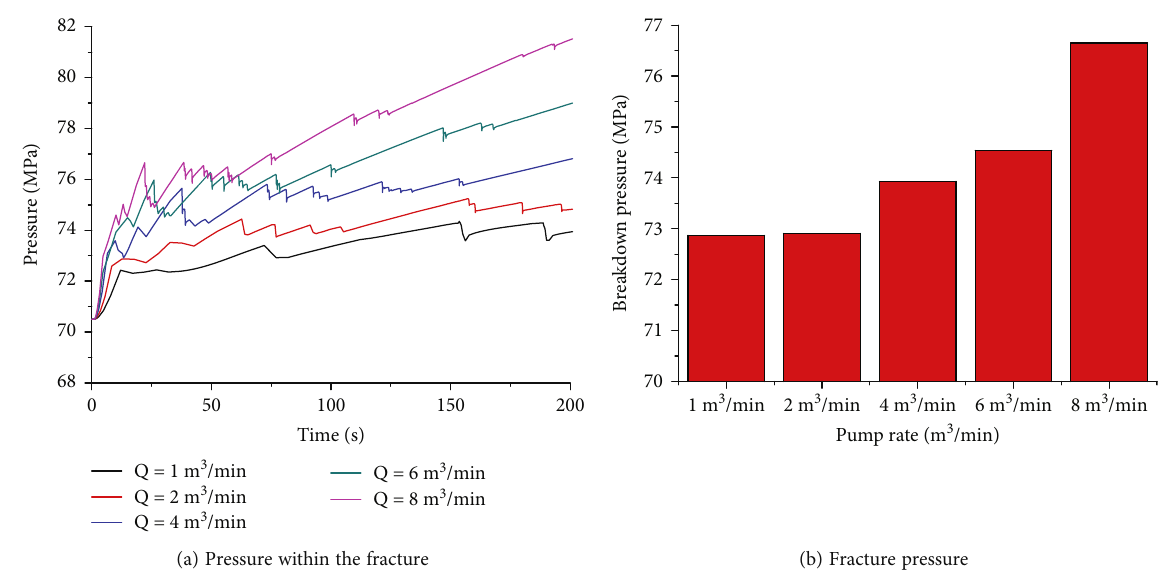
Figure 41: Pressure within the fracture and fracture pressure at the NF approaching angle of 60 ° and injection rates of 1-8 m 3